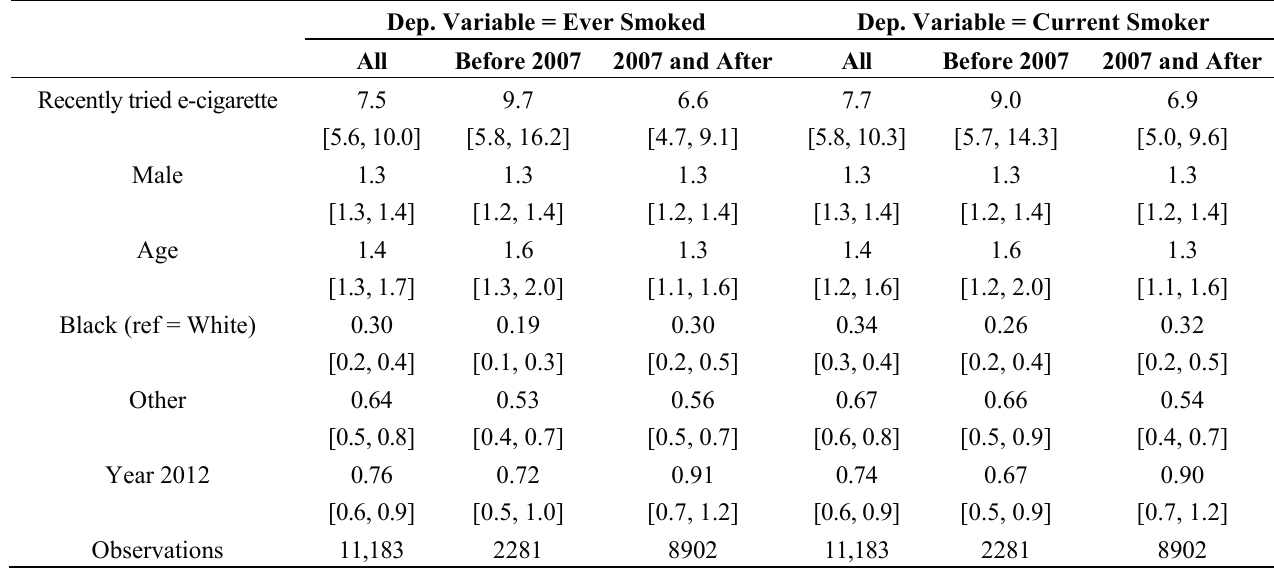
Table 8. Association of smoking and e-cigarette recent trying, by time of first trying a cigarette: before 2007 vs. later (ORs and 95% CIs).